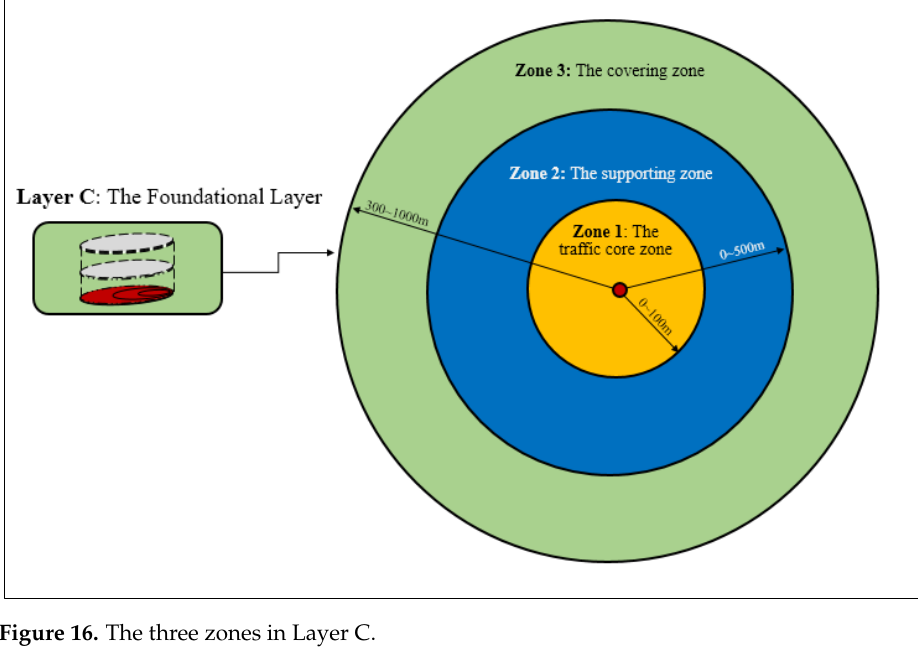
Figure 16. The three zones in Layer C.